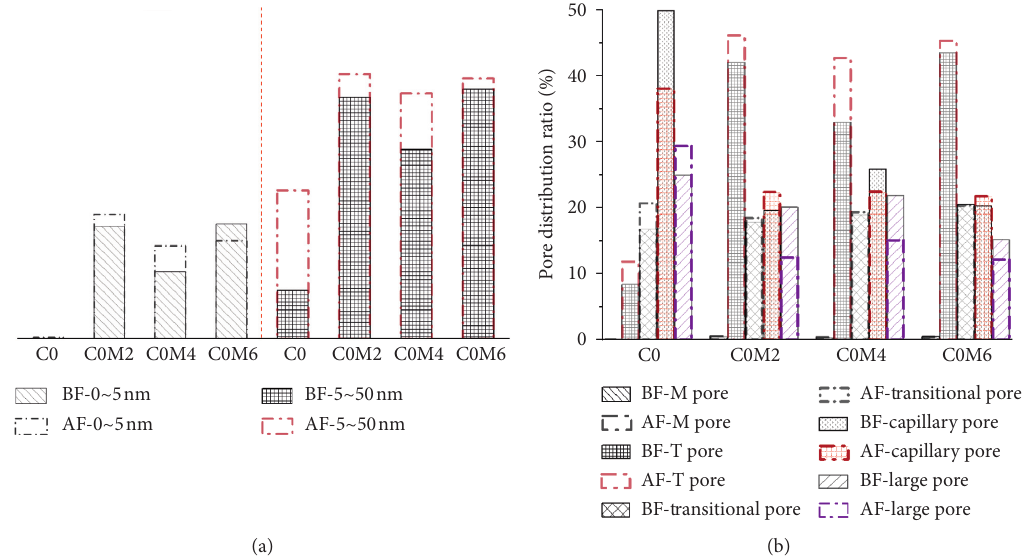
Figure 9: CGCC pore diameter redistribution diagram ( < 5, 5–50nm) and porosity distribution (histogram) before and after freeze-thaw cycles. PS: M pore: < 5nm; T pore: 5–50 nm; transitional pore: 50–100nm; capillary pore: 100–1000nm; large pore: > 1000nm.